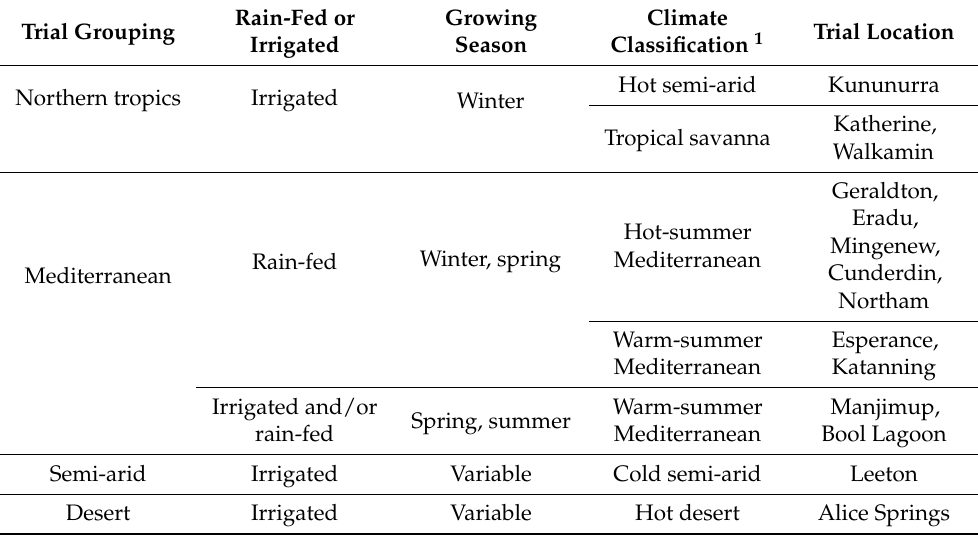
Table 2. Description and location of quinoa trial sites in